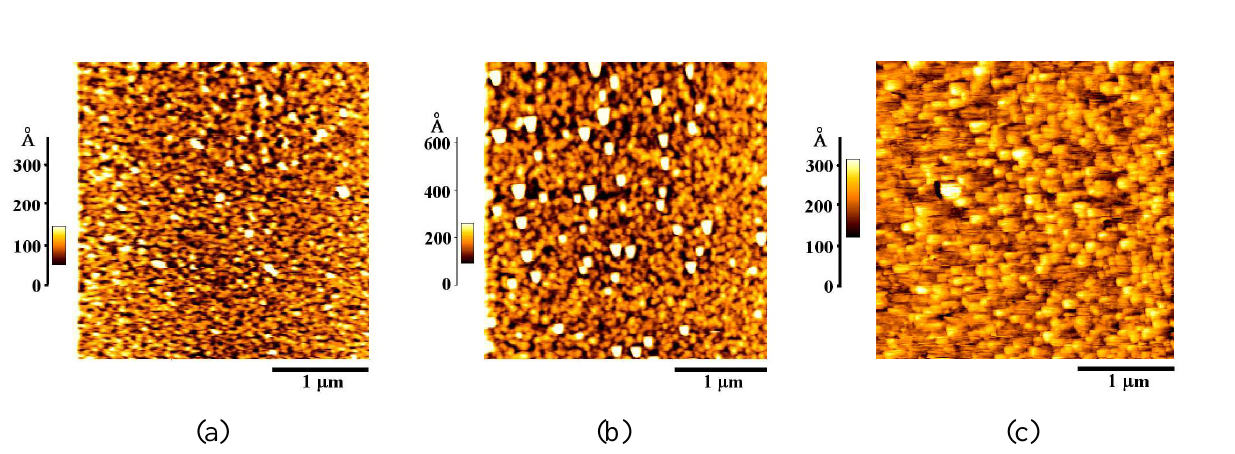
Figure 9 . AFM images of (a) BSA-immobilized Cal-4 derivative 1 SAM, (b) BSA-immobilized Cal-4 derivative 2 SAM, and (c) BSA-immobilized Cal-4 derivative 3